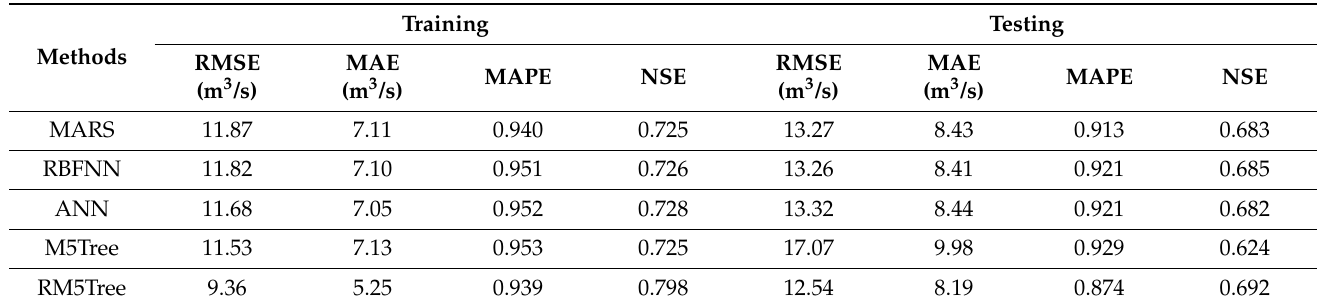
Table 3. Training and testing statistics of the RM5Tree, M5Tree, RBFNN, ANN, and MARS models in